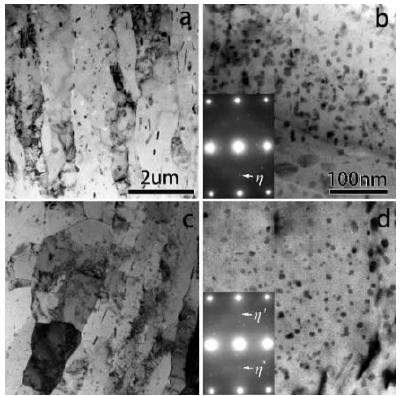
Figure 8. Microstructures in the HAZ: ( a , b ) on the advancing side with the lowest hardness; ( c , d ) on the retreating side. The insets in ( b , d ) are the corresponding SAED patterns.